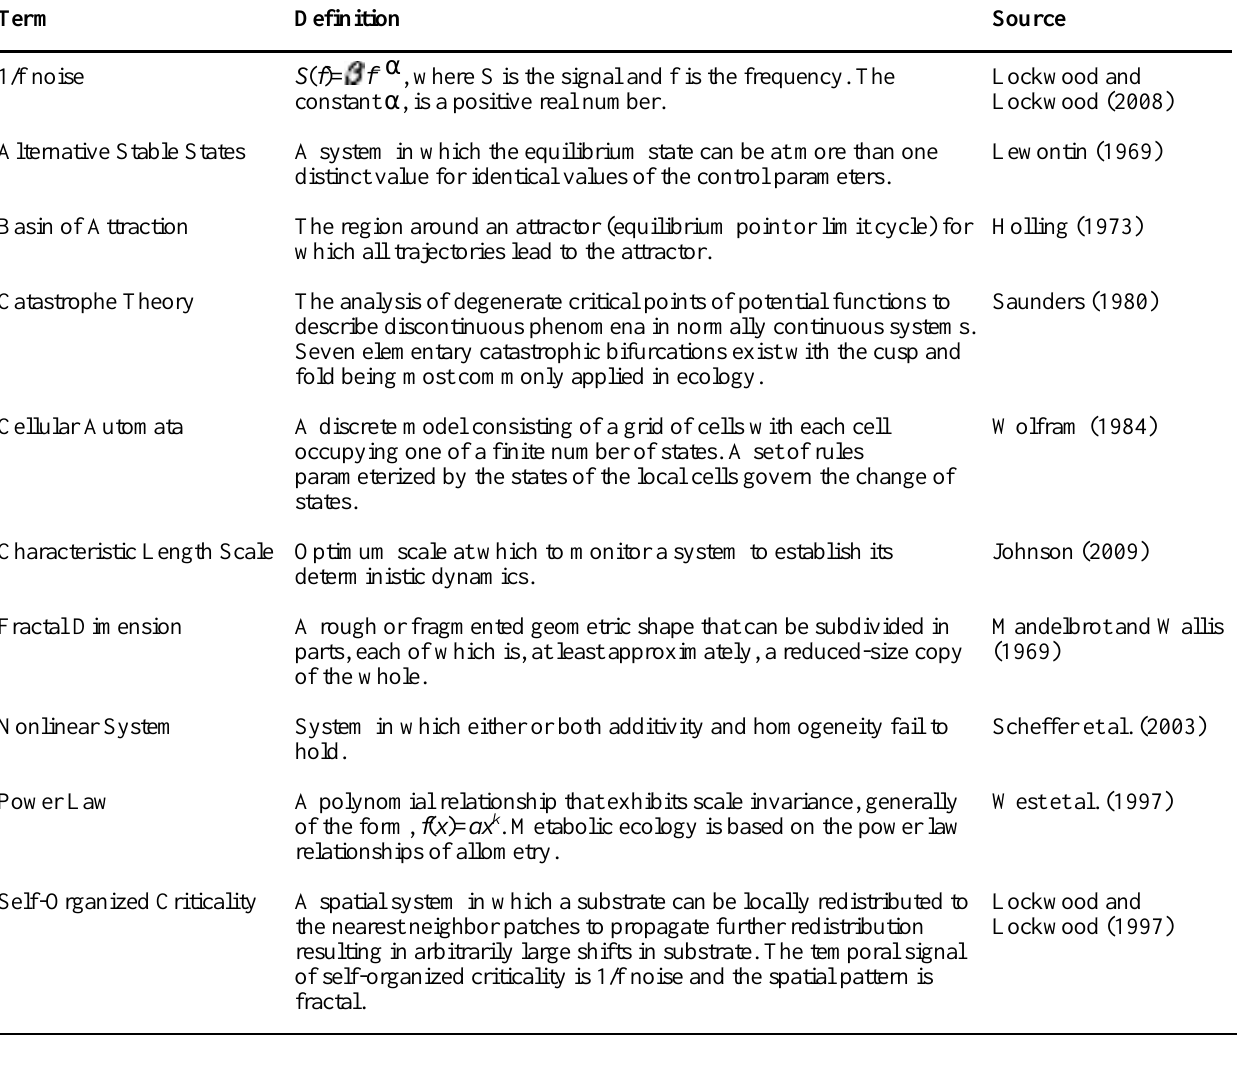
Table 1 . Glossary of ecological terms, concepts and sources used to evaluate nonequilibrium ecology and threshold behavior in ecological